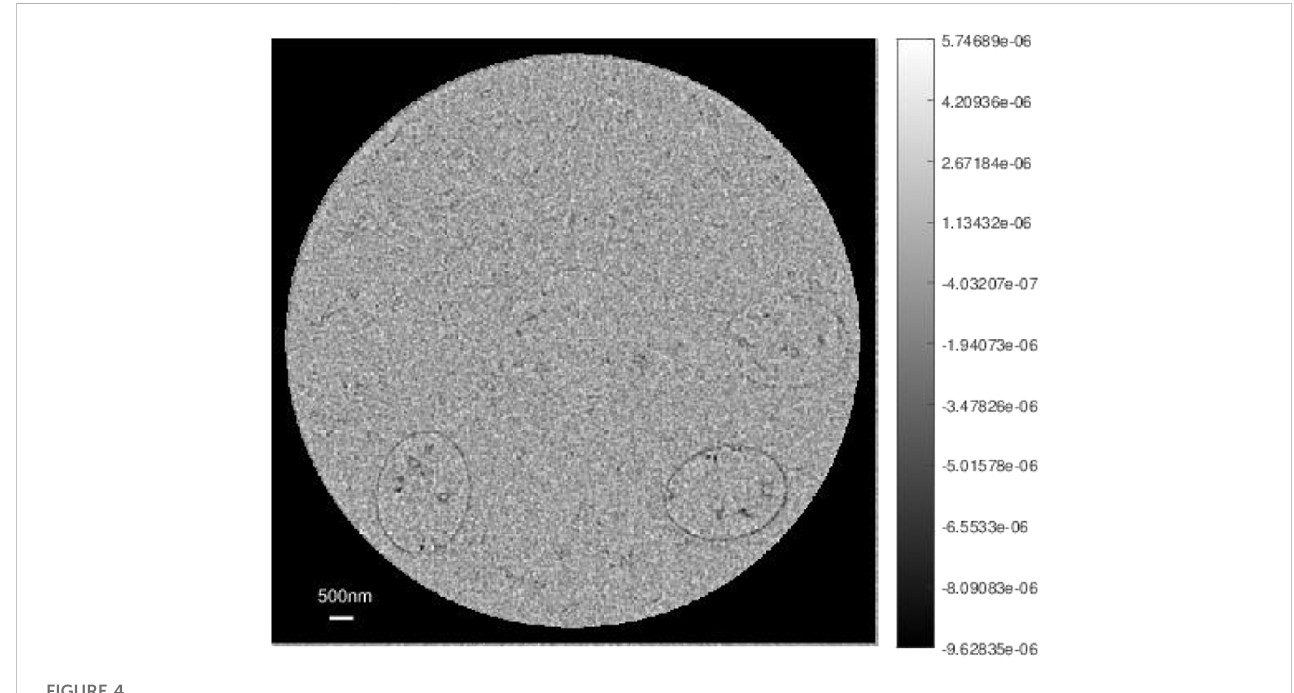
FIGURE 4 FBP result without phase retrieval.